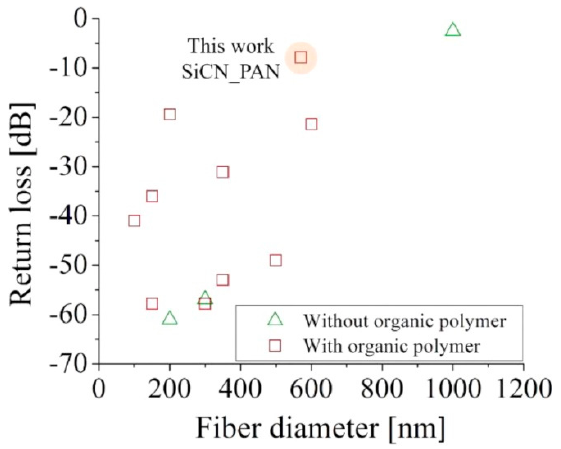
Figure 6. Relationship between diameter versus return loss of electrospun ceramic fibers from Si-based preceramic polymers. From [84], copyright (2022), with permission from Elsevier. “This work” refers to [84].